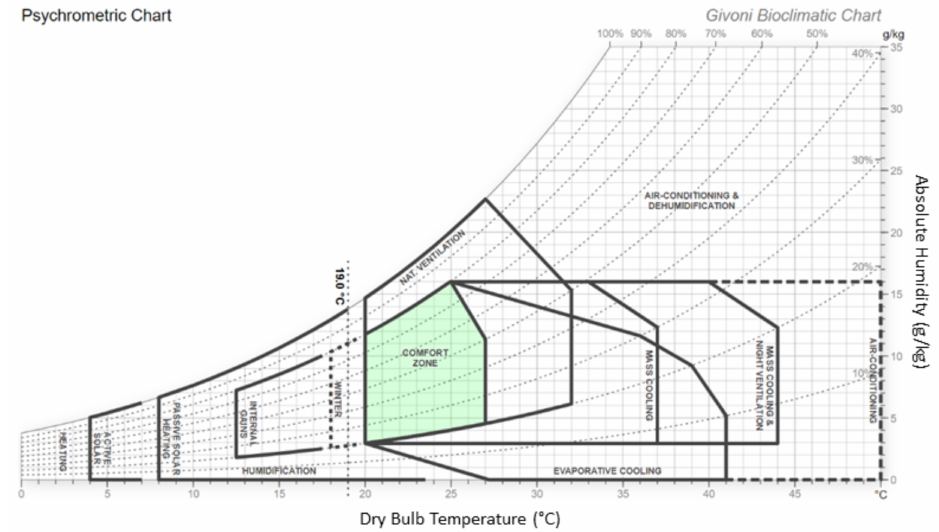
Figure 2. Givoni–Milne Bioclimatic